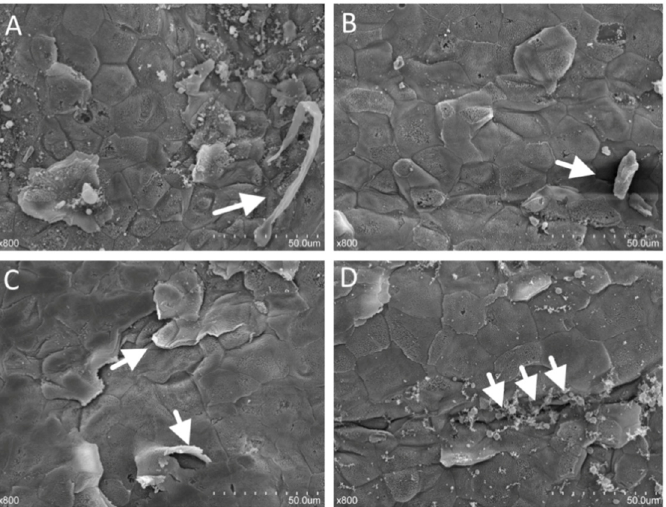
Figure 9. Different forms of stratum corneum cells disruption in the HAS group. (sloughing of the corneum, crack and budding). The epithelial keratinocytes of rumen epithelium were exfoliating, necrotic ( A , B , shown by arrows), budding ( C , shown by arrows) and forming large fissures ( D , shown by arrows).